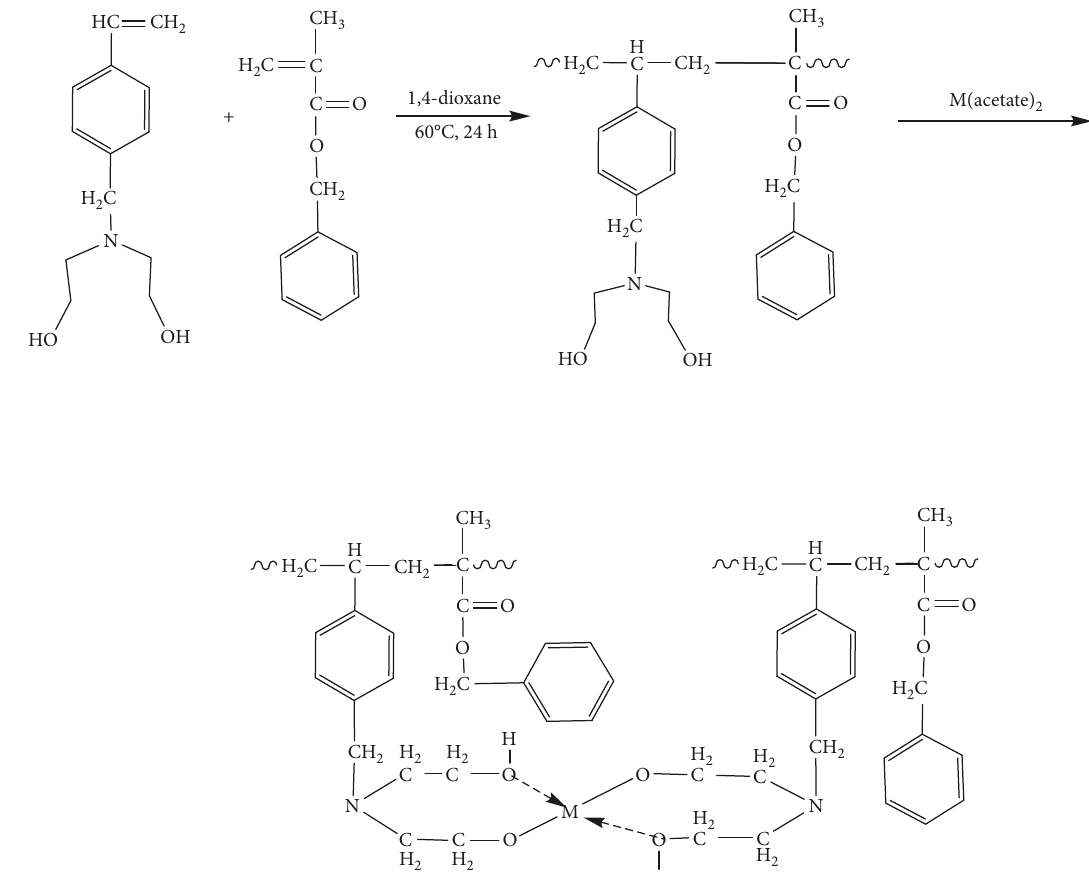
Figure 1: Synthesis reaction of poly(DEAMSt-co-BMA) and M(II)-complexes (M: Co(II), Ni(II), and